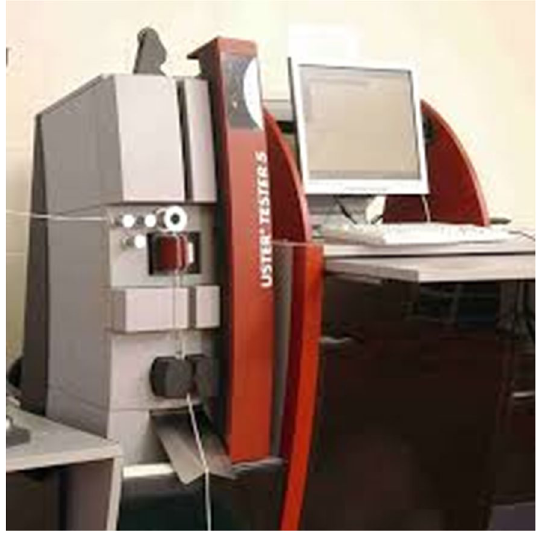
Figure 14. Uster tester five (UT5) [Courtesy of EL Sharq El Awsat Co.].